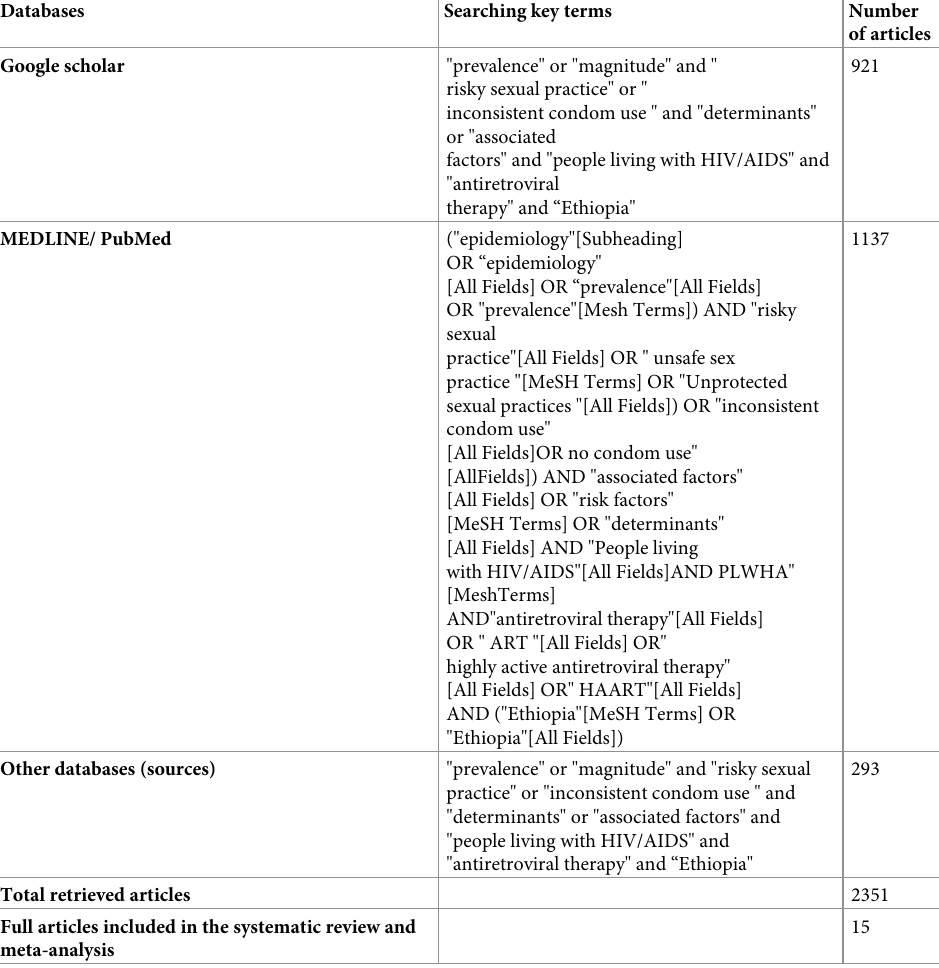
Table 1. Illustration depicting search results for the MEDLINE/ PubMed, Google Scholar, and other sources to determine the pooled prevalence of risky sexual practice and associated factors among PLWHA receiving (Antire- troviral Therapy)